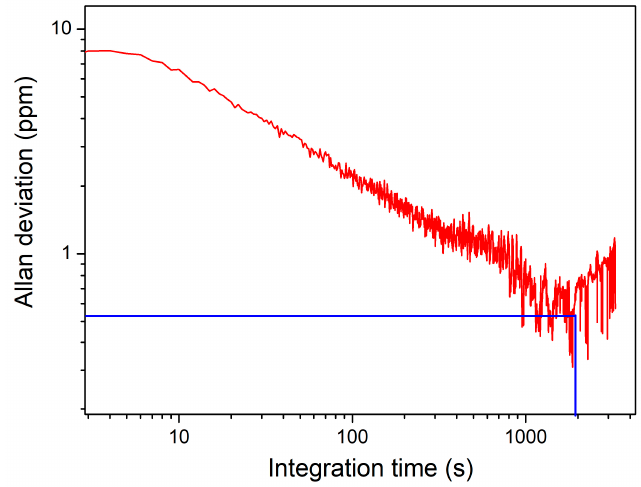
Figure 8. PAS signal with an optimum modulation depth of 0.297 cm ‒ 1 . ( a ) 2 f signal with different CO concentrations. ( b ) Signal peak value as a function of concentration.